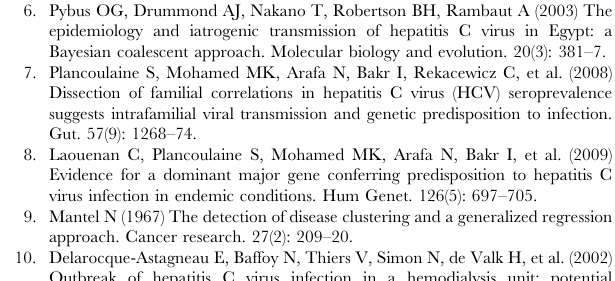
Figure S1 Scatterplot of correlation between the pair- wise genetic distances derived from NS5b and E1 regions in a subsample of 66 participants.